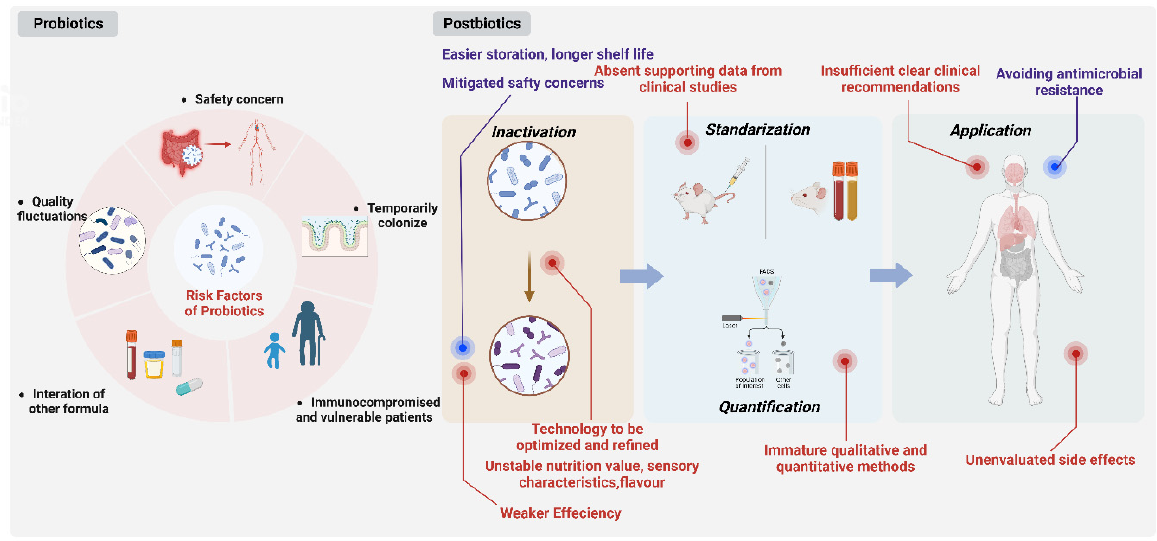
Figure 3. Comparison between probiotics and postbiotics in application.